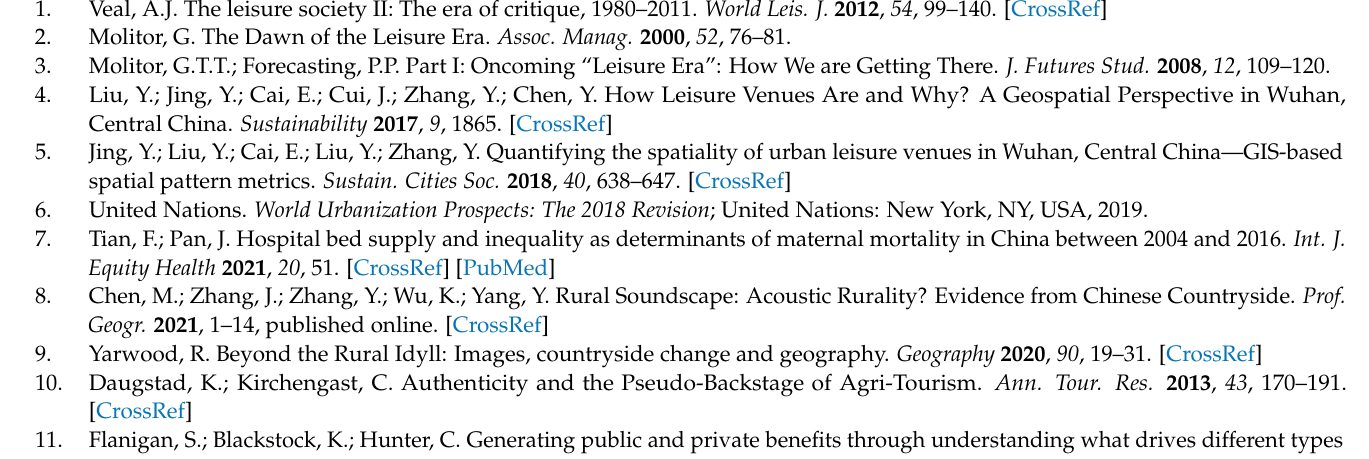
Orchard Density (/1000 km 2 )